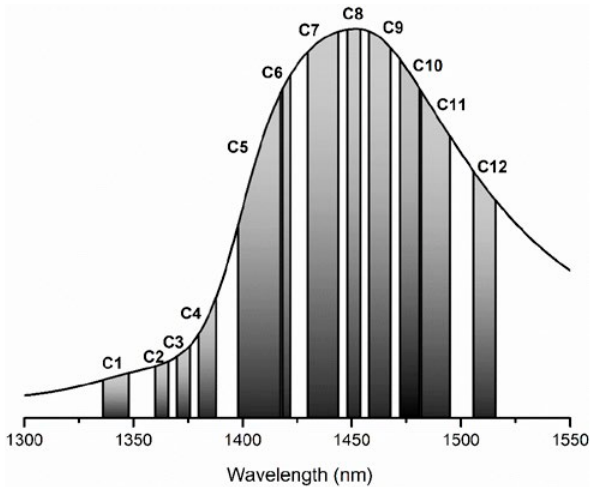
Figure 1. Schematic depiction of the water matrix coordinates (WAMACS), which are the wavelength ranges where the spectral absorption changes most in bio-aqueous systems due to pertuba- tions.